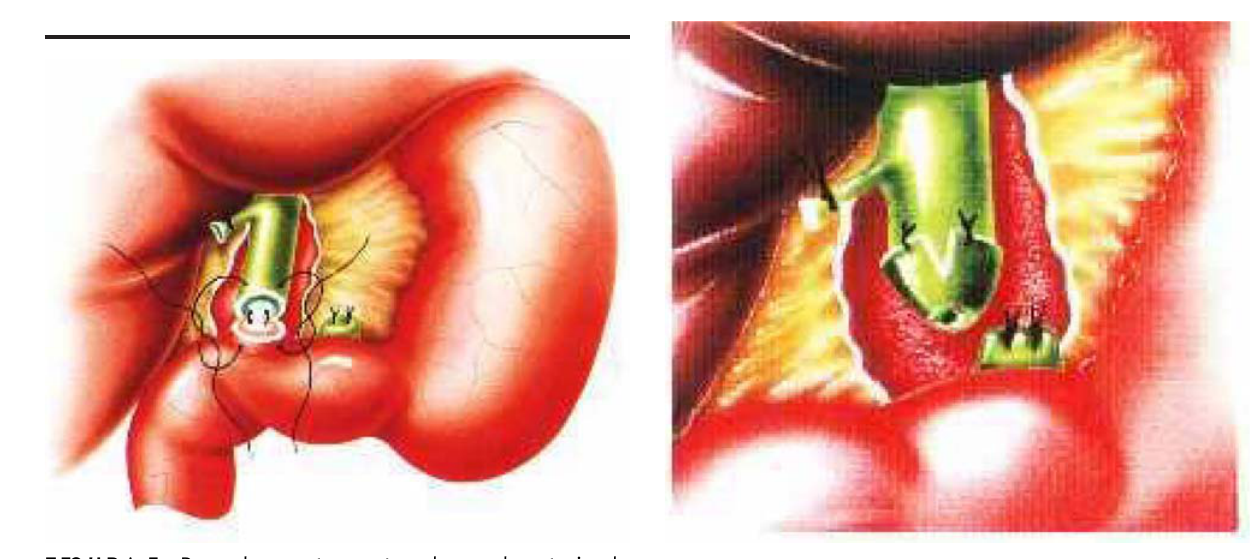
FIGURA 8 - Desenho mostra o detalhe da eversão da parede do